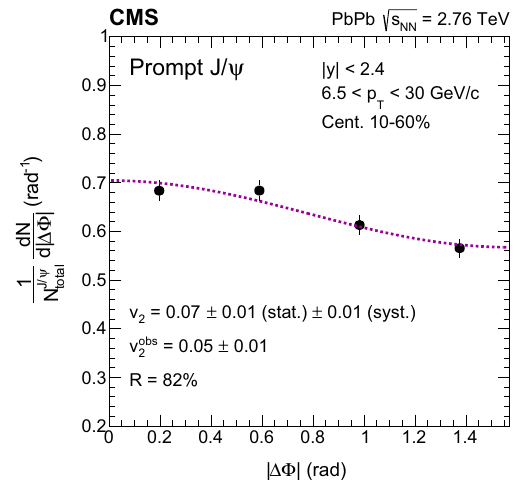
Fig. 2 The | (cid:12)(cid:4) | distribution of high p T prompt J /ψ mesons, 6 . 5 < p T < 30GeV / c, measured in the rapidity range | y | < 2 . 4 and event centrality 10–60%, normalized by the bin width and the sum of the prompt yields in all four (cid:12)(cid:4) bins. The dashed line represents the func- tion 1 + 2 v obs cos ( | 2 (cid:12)Φ | ) used to extract the v obs . The event-averaged 2 2 resolution correction factor, corresponding to this event centrality, is also listed, together with the calculated final v 2 for this kinematic bin. The systematic uncertainty listed in the legend includes the 2.7% global uncertainty from the event plane measurement in which results are reported: 10–20%, 20–30%, and 30–